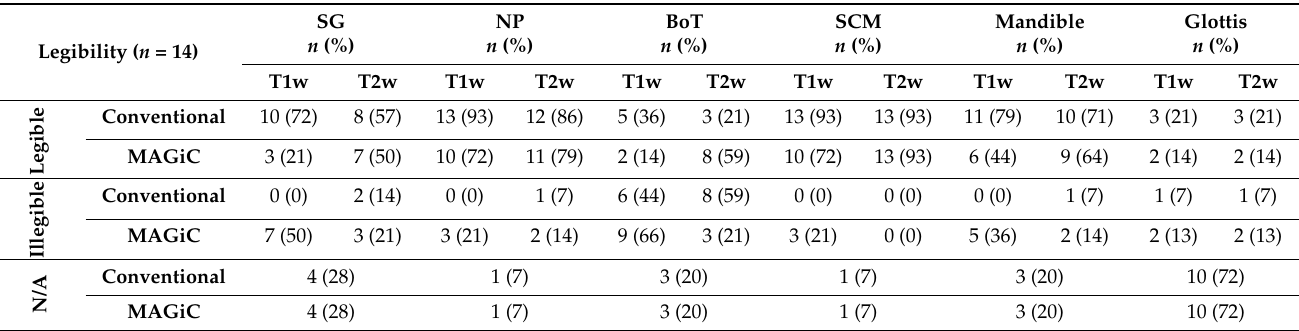
Table 4. Legibility of anatomic and morphologic